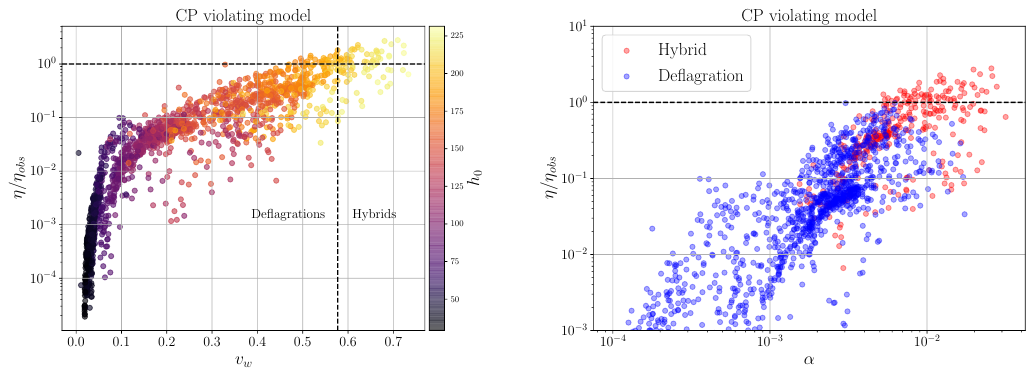
Figure 10 . Results for the baryon asymmetry of the Universe (BAU) normalized to its observed value as a function of the wall velocity (left panel) and the strength α 0 of the phase transition (right panel). The coloured side-bar alongside the left panel indicates the value of the Higgs bubble profile amplitude h 0